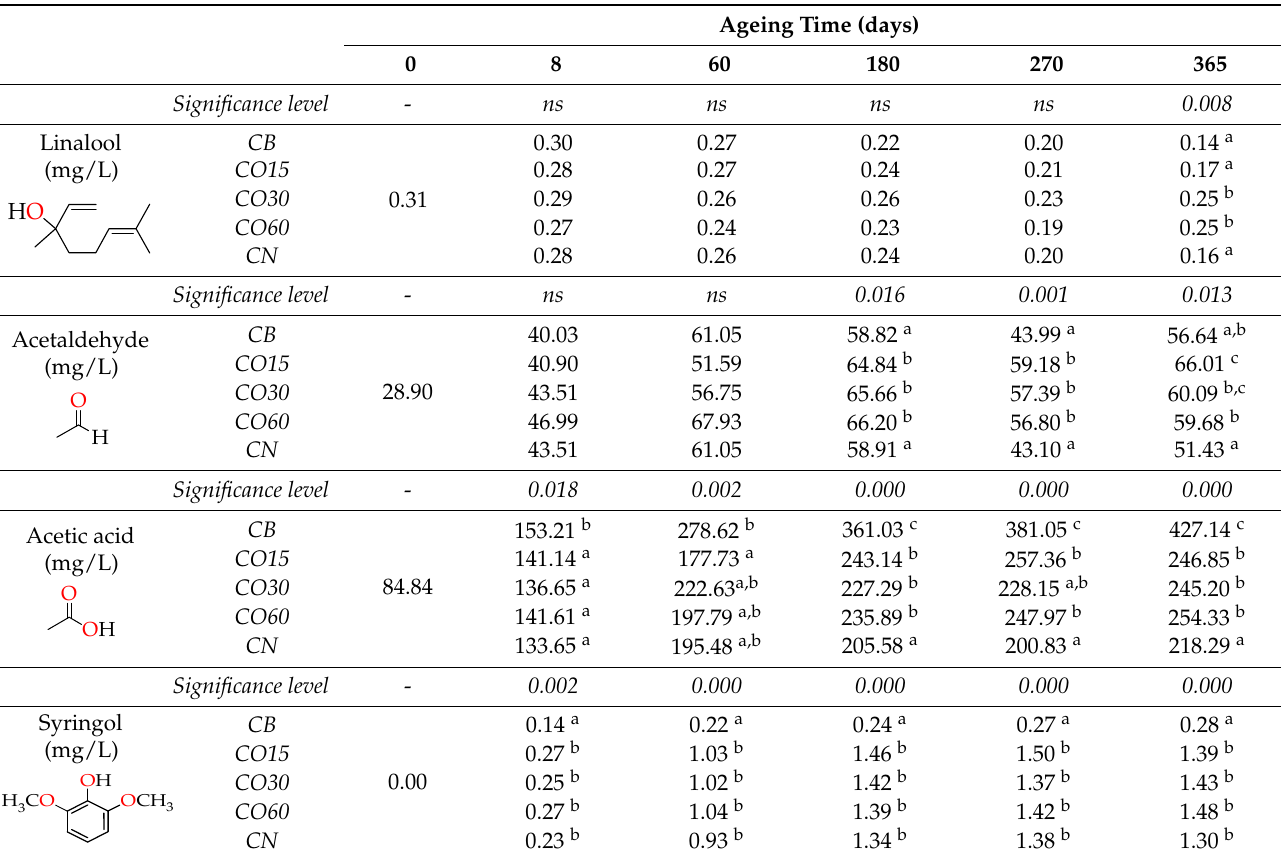
Table 1. Concentration (mg/L) of target volatile compounds quantified in the wine spirits sampled from different ageing modalities over the time (8, 60, 180, 270 and 365 days) and ANOVA summary.